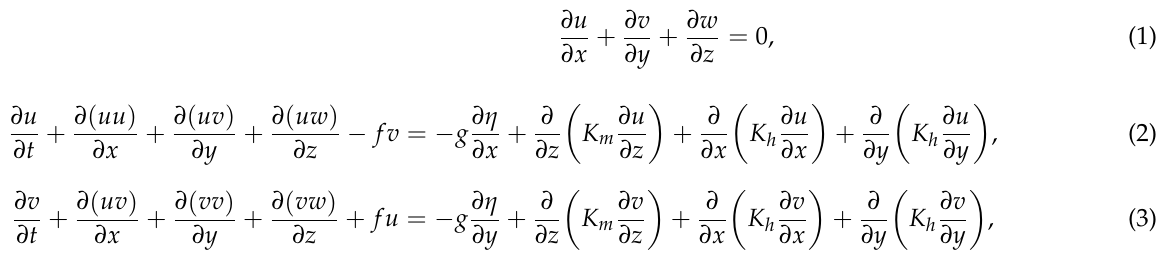
Table 2. Notations for the governing equations of the three-dimensional hydrodynamic model. Variables Explanation u ( x , y , z , t ) velocity of water in x direction v ( x , y , z , t ) velocity of water in y direction velocity of water in z direction acceleration due to gravity angle of geographical latitude magnitude of the angular velocity of the Earth Coriolis parameter